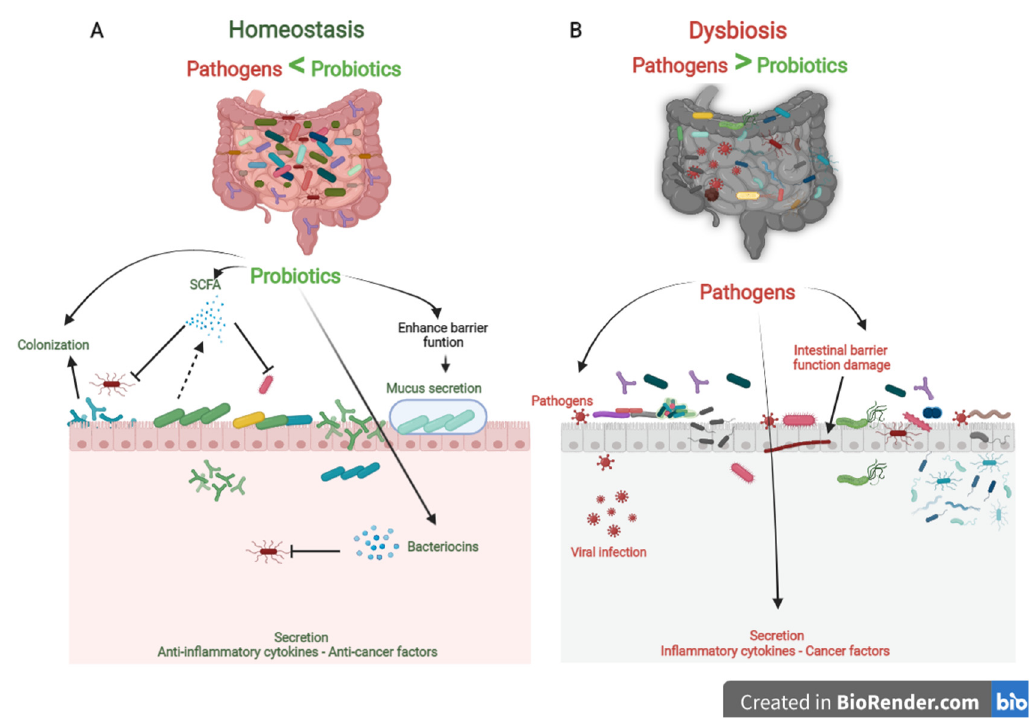
Figure 1. The role of probiotics in competitive exclusion of pathogens. ( A ) Gut microbiota homeostasis refers to probiotics that colonize intestinal epithelial cells. Probiotics produce SCFAs and bacteriocins that prevent viral infection and other pathogens. In addition, probiotics boost anti-inflammatory cytokines and anticancer factors, which prevent the development of chronic diseases. ( B ) In contrast, gut microbiota dysbiosis refers to a decrease in microbial diversity caused by the loss of beneficial bacteria and an increase in pathogen microbiome, which is linked to an increased risk of chronic diseases and viral infections.